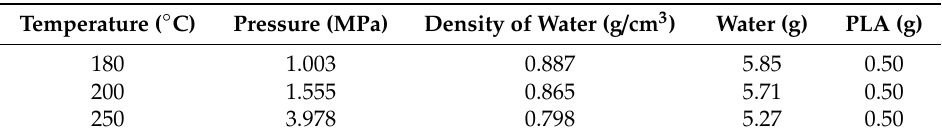
Figure 1. Apparatus for the decomposition of polylactic acid (PLA) using sub-critical water. Table 1. Experimental conditions.